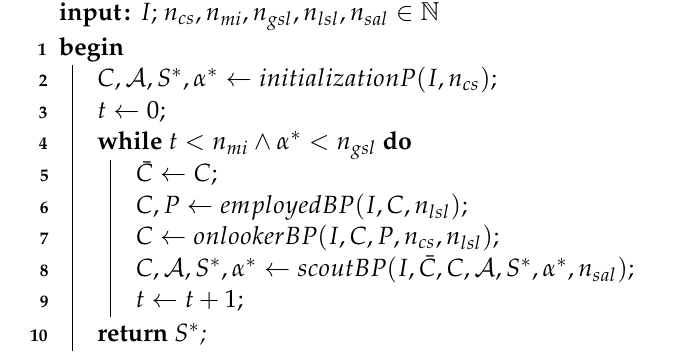
Algorithm 1: Main CARP-ABC